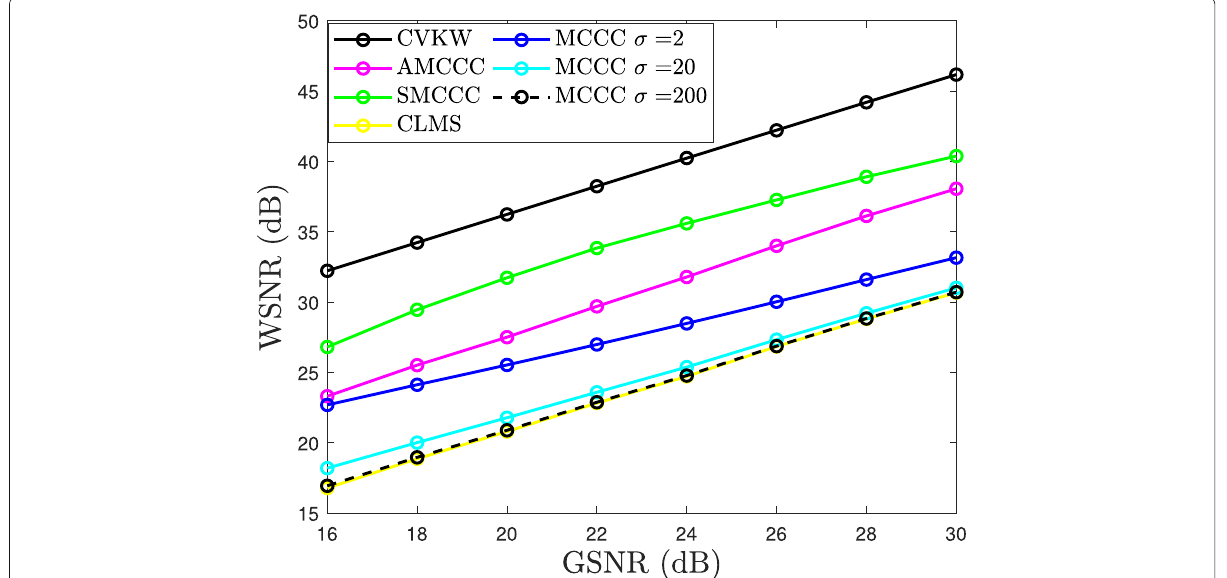
Fig. 5 Performance comparison among several methods in terms of WSNR as a function of GSNR for α =